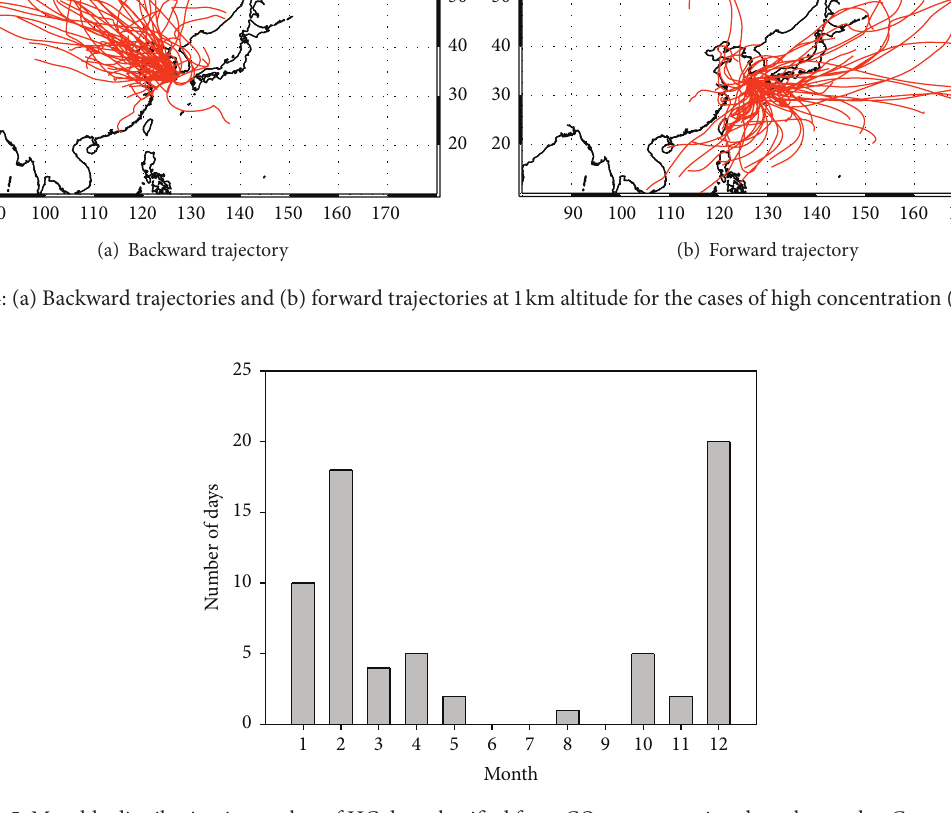
Figure 5: Monthly distribution in number of HC days classified from CO 2 concentration data observed at Gosan